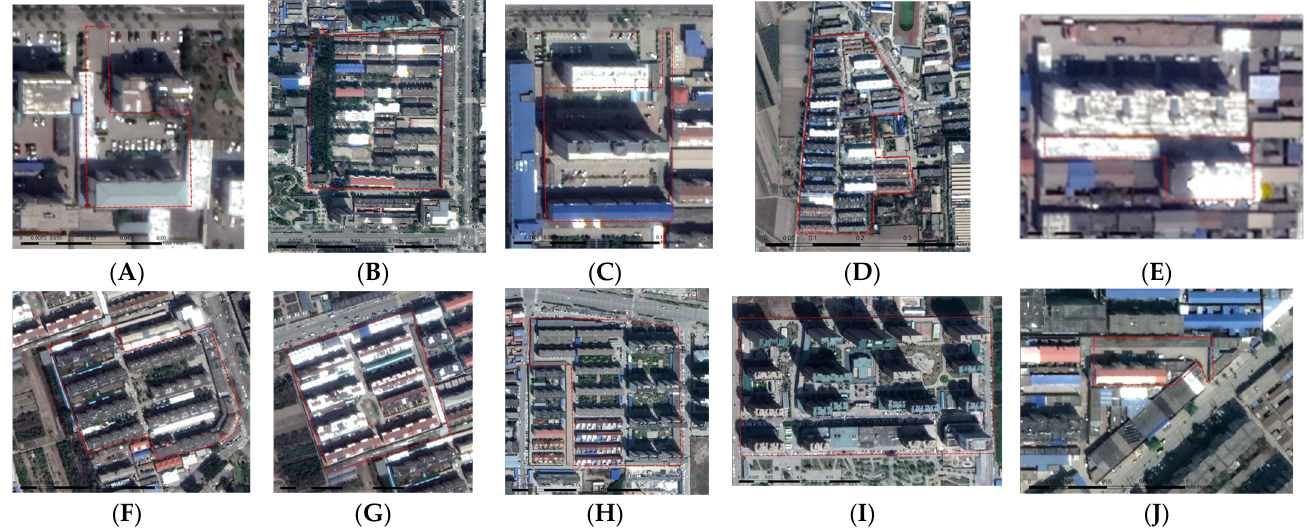
Figure 6. Aerial photos of the ten gated communities. ( A ) China Mobile Community; ( B ) Jinzhong Second Hospital Community; ( C ) Transportation Administrative Community; ( D ) Textile Mill Community; ( E ) China Mobile Community; ( F ) Minsheng Community; ( G ) Houchengjiayuan Community; ( H ) Tianlixingdu Community; ( I ) Yujinghuafu Community; ( J ) Xiangyangju Community. Meanwhile, information about the spatial and functional structure of the ten gated communities is shown in Table 4 below.